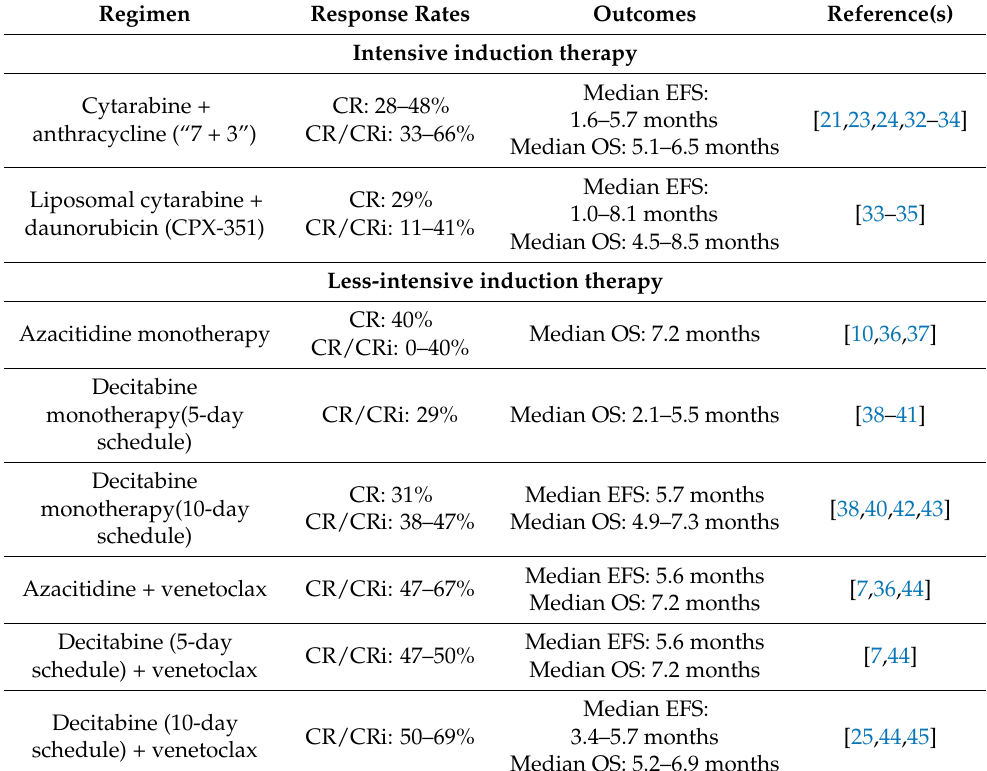
Table 1. Summary of the experiences with the currently available frontline therapies for TP53 - mutated